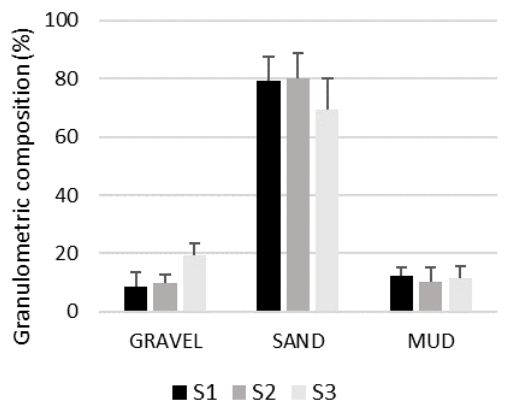
Figure 3. Granulometric composition of the sediment collected at stations S1 to S3 in the Kaštela Bay (Adriatic Sea, Croatia).